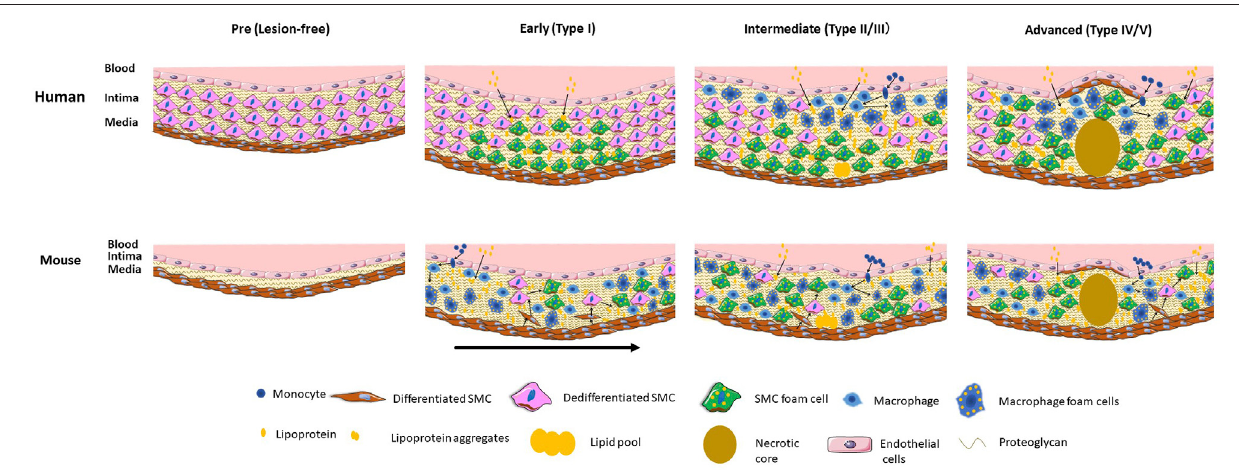
FIGURE 1 | Stages and relative localization and contribution of SMCs and macrophage and their foam cells to human and mouse atherosclerosis. Human atherosclerosis is preceded by the formation of a thick intimal layer composed of SMCs and their secreted proteoglycans, known as diffuse intimal thickening. Atherogenic lipoproteins diffuse into the intima over decades and are deposited primarily in the deep intima, resulting in initial SMC foam cell formation. In intermediate lesions there is expansion of the SMC foam cell pool, and in fi ltration of circulating monocytes that differentiate to macrophages and take up lipids to become foam cells.Intheadvancedlesionalargenecroticcoreformsalongwitha fi brouscapofSMCs.DirectSMC-macrophageinteractionsoccurprimarilyintheupperintimawhere most macrophages are located. Mouse atherosclerosis develops on a background of a healthy artery lacking diffuse intimal thickening. Severe dyslipidemia in mouse modelsinducesendothelialin fl ammationandin fl uxoflipidsandmonocytesthatdifferentiatetomacrophagesandtakeuplipidstobecomefoamcells.Cytokine-induced SMCmigrationoccursfollowedbyproliferationanddedifferentiationofSMCsanduptakeoflipidstobecomefoamcells.Inlaterearlyandmoreadvancedmouselesions SMCs make up the majority of foam cells. Direct as well as indirect macrophage-SMC interactions occur throughout the full thickness of the mouse lesion. The early mouse lesion shows different stages of development with the arrow indicating progression. In both humans and mice macrophage foam cells store cholesteryl ester droplets in the cytoplasm whereas in SMC foam cells the cholesteryl ester droplets appear mainly in lysosomes. Part of the fi gure was generated using Servier Medical Art, licensed under a Creative Commons Attribution 3.0 unported license.